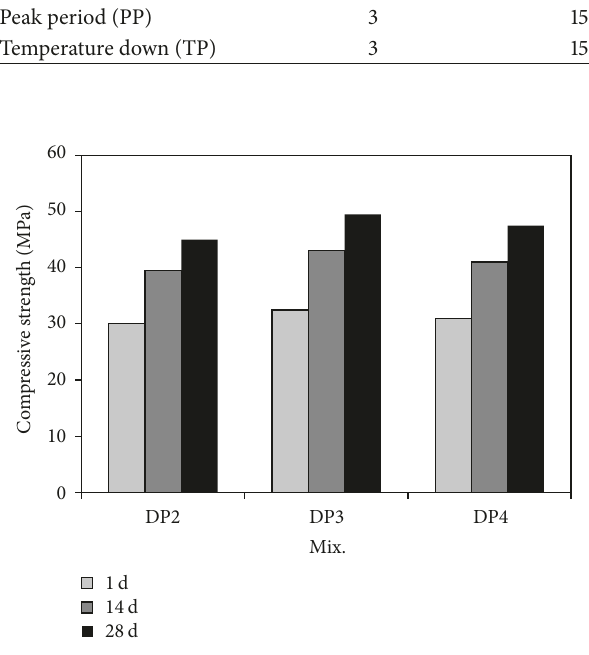
Figure 4: Compressive strength versus delay period. Figure 5: Compressive strength versus temperature